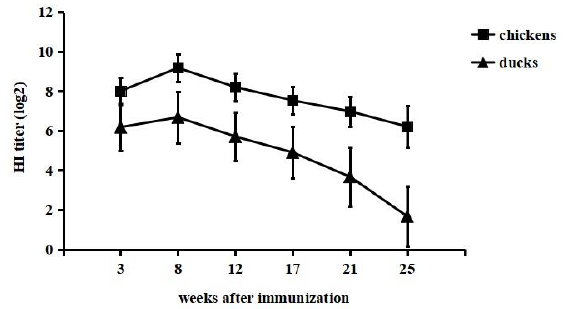
Figure 1. Antibody responses in chickens and ducks immunized with inactivated vaccine. Twenty- eight-day-old SPF chickens and ducks were given the developed inactivated vaccine subcutaneously. At 3, 8, 12, 17, 21 and 25 weeks after immunization, sera were collected for HI antibody determination by the haemagglutination inhibition (HI) test .